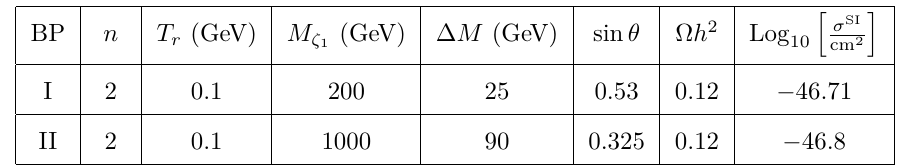
Figure 6 . The same as figure 4 but for a choice of larger T r = 1 GeV.